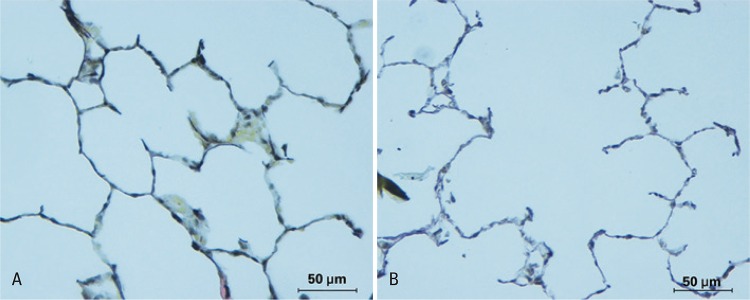
Fotomicrografias do parênquima pulmonar (Verhoeff), aumento de 400x. (A) Pulmão naive demonstrando integridade dos componentes elásticos da parede alveolar, contrastando com áreas desnudas ao longo dos septos associadas ao adensamento de fibras elásticas na parede alveolar e diminuição da concentração de fibras elásticas no pulmão enfisematoso (B)